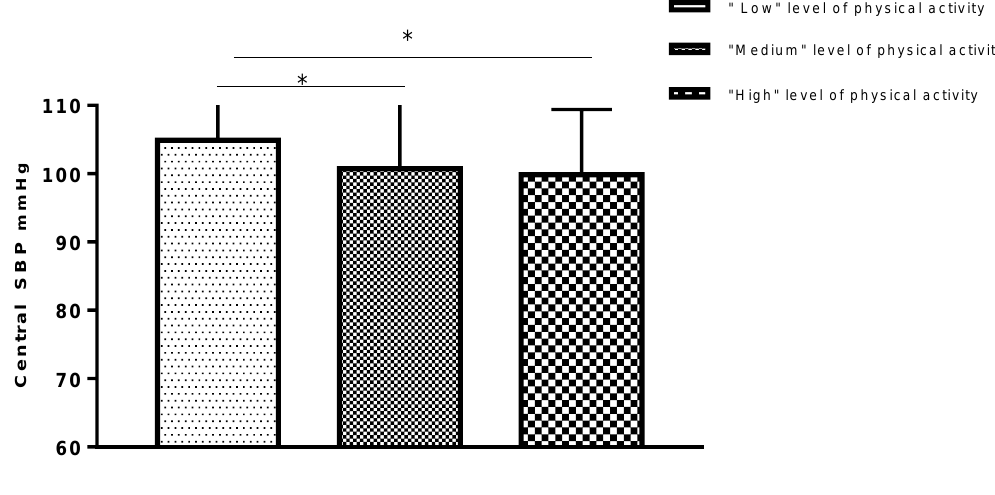
Figure 2. Difference of central blood pressure (cSBP, mmHg) among levels of moderate-vigorous physical activity. Legend: “Low”: < 600 MET-minutes / week; “Medium”: 600–3000 MET-minutes / week; physical activity. Legend: “Low”: <600 MET-minutes/week; “Medium”: 600–3000 MET- “High”: > 3000 MET-minutes / week. SBP: systolic blood minutes/week; “High”: >3000 MET-minutes/week. SBP: systolic blood pressure